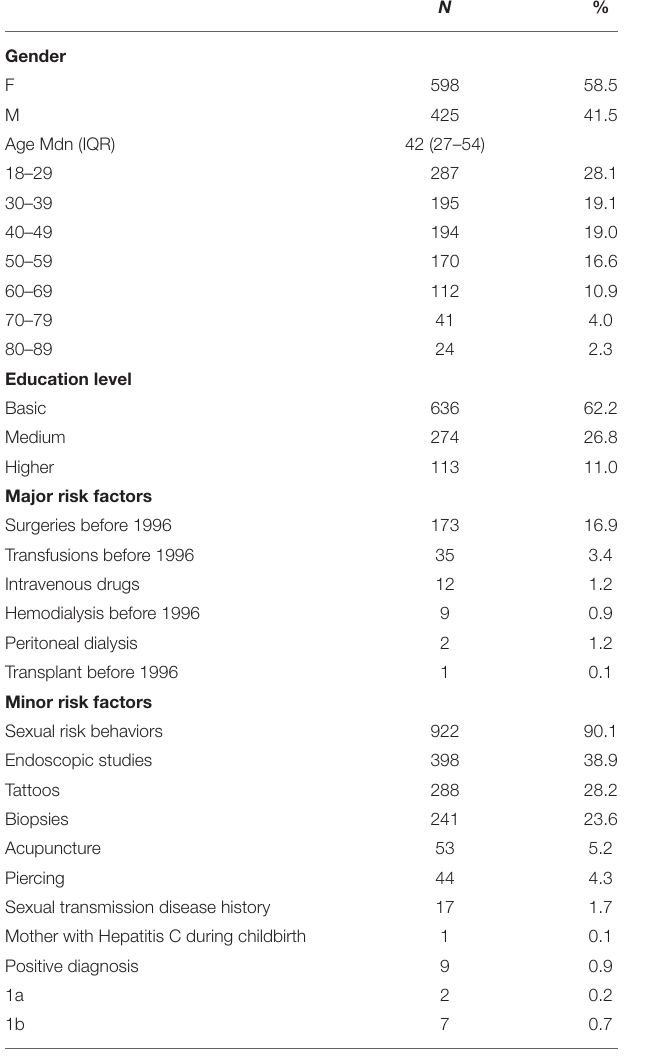
TABLE 2 | Comparison of characteristics of patients stratified by confirmed or unconfirmed HCV